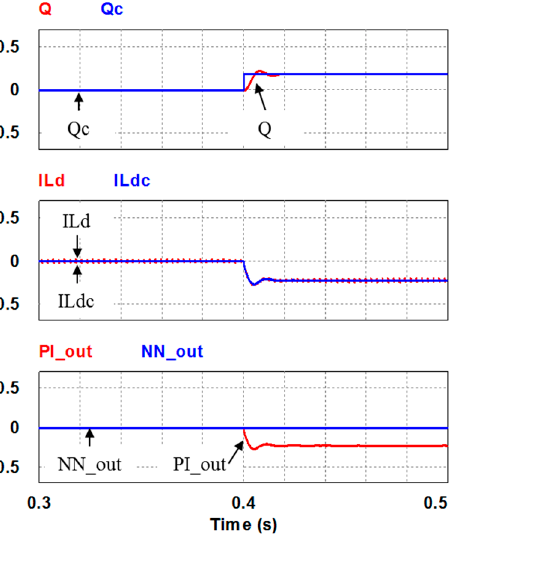
Figure 16. Case 1 simulation result: ( a ) reactive power feedback and its command, inductor current power and its com- mand, and reactive power controller outputs (all control signals are in V); ( b ) the accumulated reactive power control error.